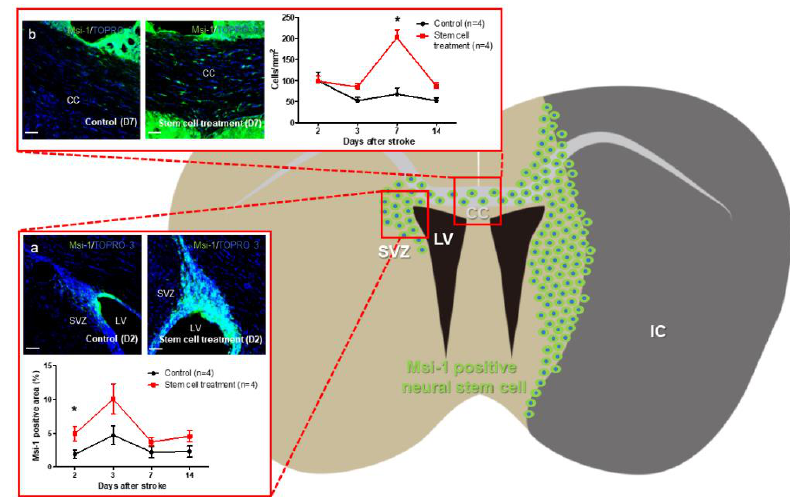
Figure 2. Sprague-Dawley rats were anesthetized with isoflurane, and a 75-min transient middle cerebral artery occlusion (MCAO) was performed with a 4.0 nylon monofilament suture coated with silicone (4039PK10; Doccol). One day after MCAO, the rats underwent stem cell transplantation. Mesenchymal stem cells (1 × 10 6 cells) or phosphate-buffered saline were injected into the internal carotid artery through a catheter inserted from the stump of the distal external carotid artery to the internal carotid artery through the bifurcation. After deep anesthesia, the brain was excised following perfusion fixation using 4% paraformaldehyde. After adequate fixation, a 40- µ m frozen coronal section was made [11]. Three coronal sections of the brain (1.0 ± 0.6 mm before the bregma) were stained using Musashi-1 (rat anti-Musashi-1 [Msi-1]: Medical and Biological Laboratories Co. Ltd., Nagoya, Japan; 1:100). The area of Msi-1-positive neural stem cells was measured using WinRoof software (Mitani Corporation; Tokyo, Japan) in the subventricular zone (SVZ). The Msi-1-positive neural stem cells were measured by counting Msi-1- and TOPRO-3- double positive cells in the corpus callosum (CC). ( a ) The Msi-1-positive area in the SVZ of the contralateral hemisphere in the stem cell treatment group was significantly larger than that in the control group 2 days after MCAO. ( b ) Seven days after MCAO, the number of Msi-1-positive cells in the CC in the stem cell treatment group was significantly higher than that in the control group. All data are presented as means ± SEM * p < 0.05, (student t -test). IC; infarct core: LV; lateral ventricle.